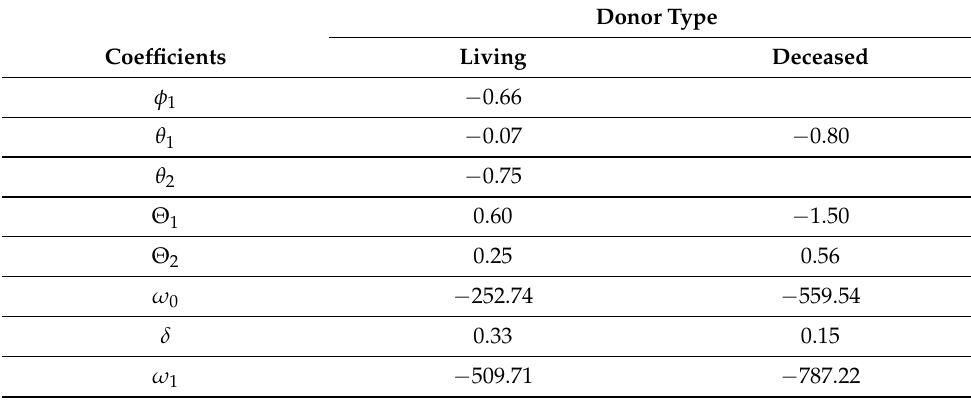
Table A1. ITSA model parameter estimates for donor types.